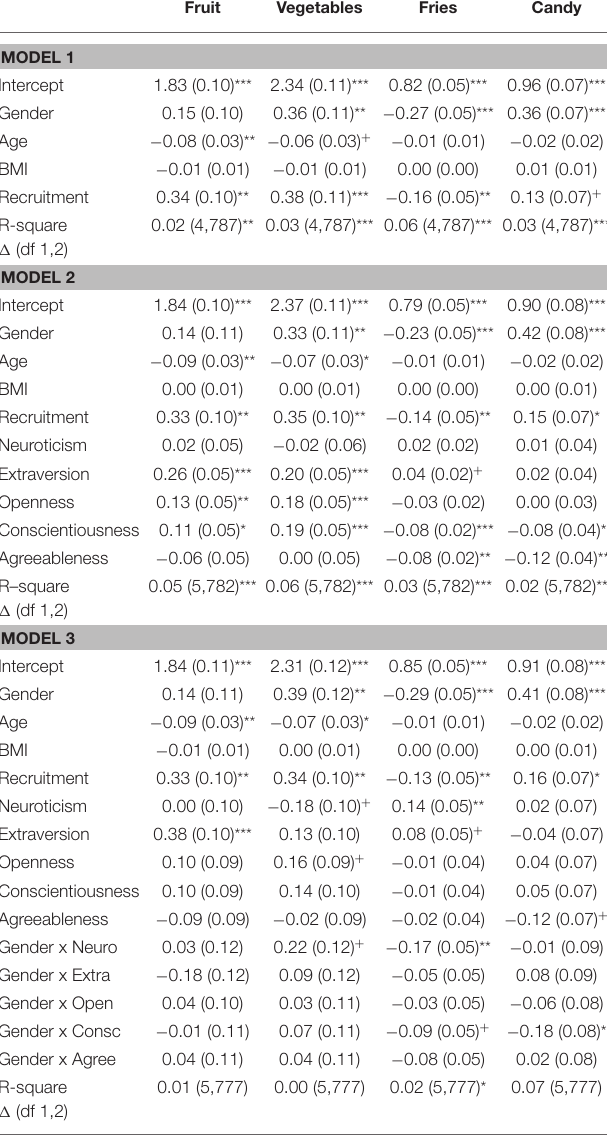
TABLE 3 | Results of hierarchical regression analyses predicting young adults’ fruit and vegetable consumption and unhealthy foods in Sample 2 ( N =